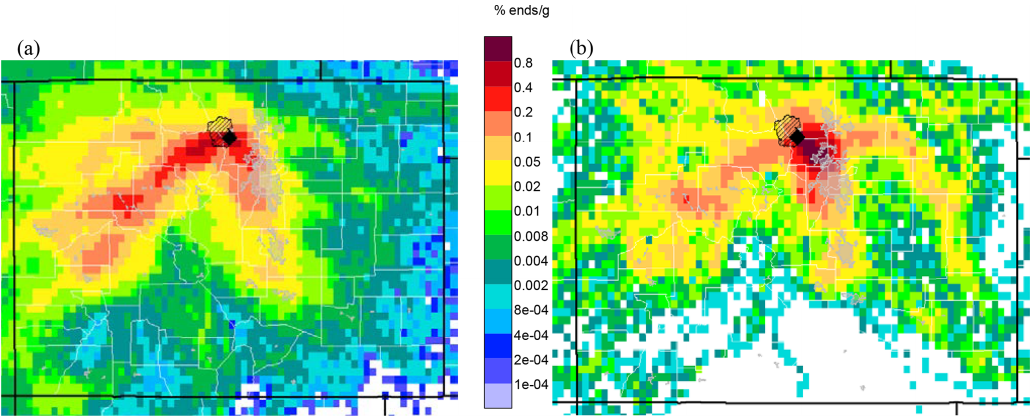
Figure 4. Residence time maps showing areas up to 2 days upwind of ROMO-LP (black diamond) during (a) all hours of the study period (17 July–4 September 2014) and (b) during hours with ethane > 90th percentile. Colors indicate the relative frequency of transport. Light- grey overlay indicated urban areas. Units are the percent of total endpoints in each grid cell. Endpoints are upwind air mass locations calculated every hour for 2 days back in time for every trajectory that arrived at the receptor during the duration of the study